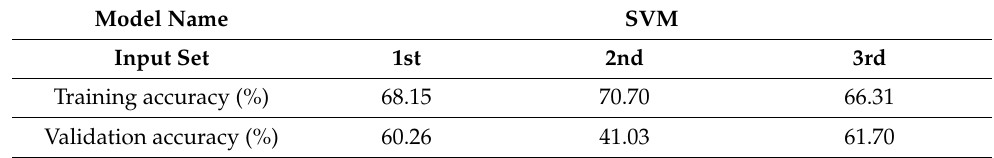
Table 4. Results of SVM